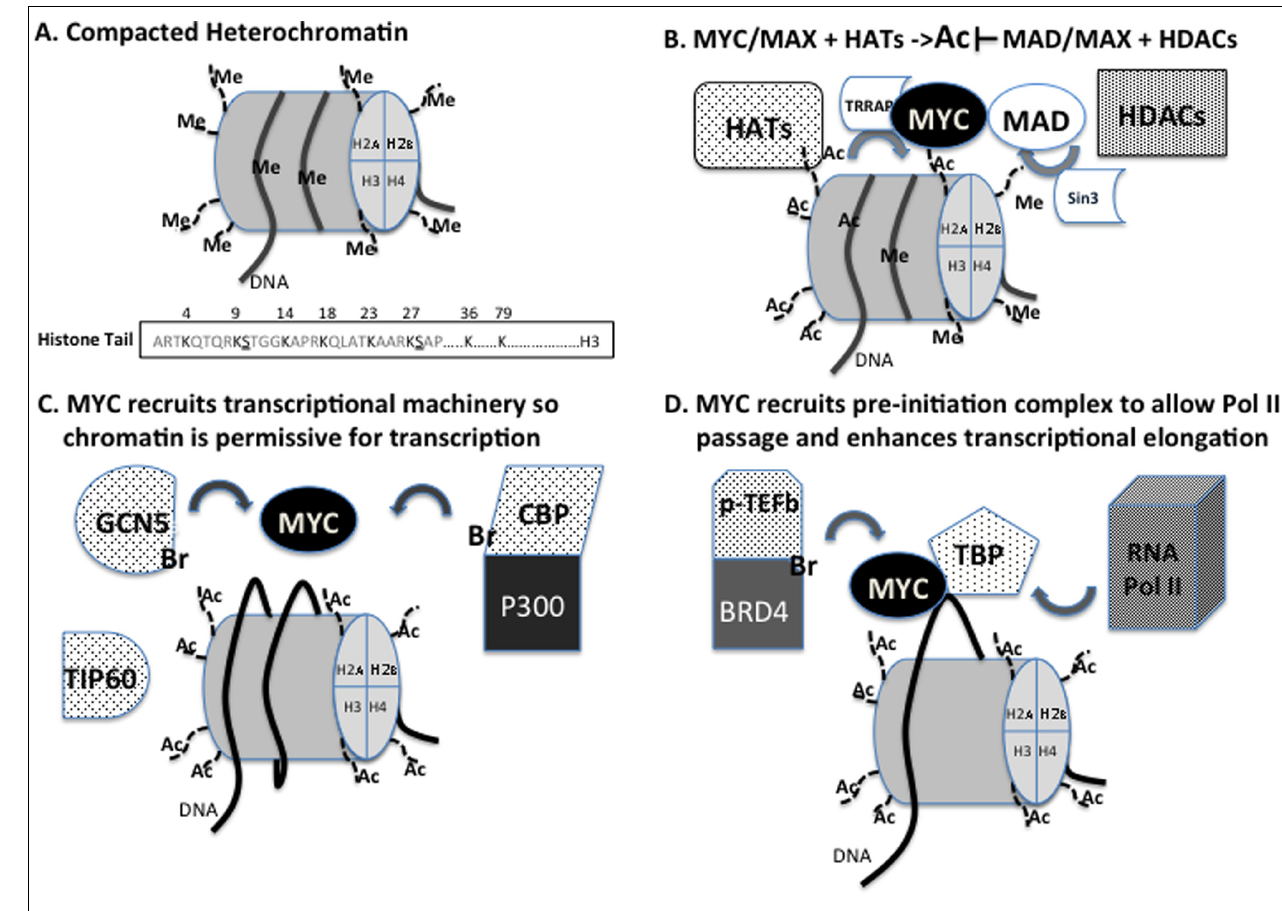
FIGURE 2 | (A) Compacted heterochromatin is characterized by specific methylation of H3K9 and H3K27 is often correlated with decreased transcription.The EZH2 component of PRC2 contains the H3K27methylase while EHMT2 or G9a contains the H3K9 methylase.The methylation status of these amino acids is regulated by demethylases such as LSD1, JMJD2, and UTX.The subsequent acetylation (Ac) of H3K9 by GCN5 and H3K27 by CBP/p300 are associated with relief of gene suppression. (B) MYC recruitsTRRAP to target loci to mediate MYC binding to histone acetyltransferases (HATs). Recruited HATs acetylate histone components to promote transcription. Conversely, MAD recruits Sin3 to target loci to mediate MAD binding to histone deacetylases (HDACs). Histone deacetylation